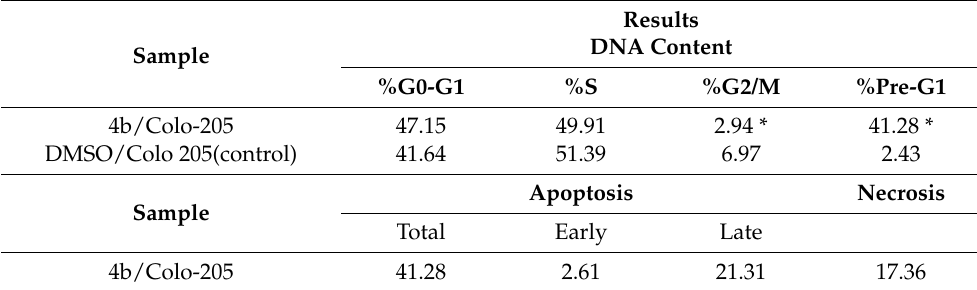
Table 4. DNA content in the cell cycle of the COLO-205 cancer cell line after treatment with 4b and DMSO control, and the effect of compound 4b on the percentage accumulation of cells at phases of cell cycle and on distribution of apoptotic cells in the annexin V-FITC experiment of the COLO-205 cancer cell